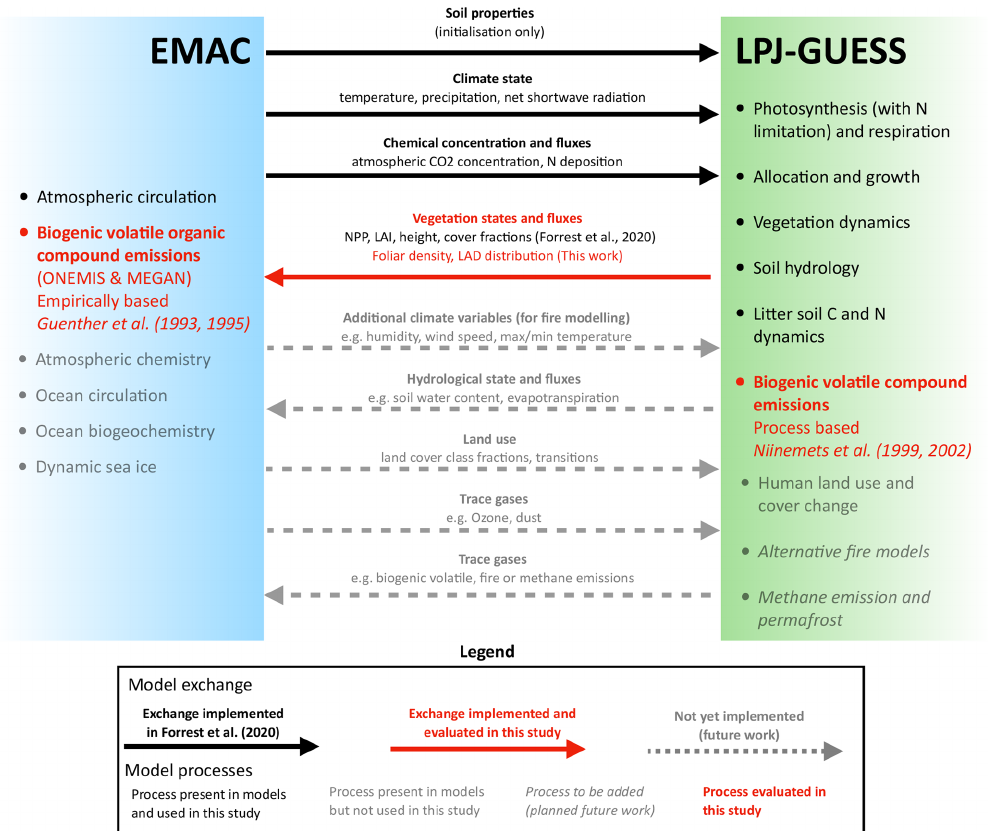
Figure 1. The main processes and exchanges in the coupled model framework adopted from Forrest et al. (2020). Model exchanges in normal black text were included in Forrest et al. (2020) and used in the simulations presented here. Exchanges in red are implemented in this work, while exchanges with grey text and grey dotted arrows are not currently included in the framework but are planned for use in future work. Model processes in normal black text were included in Forrest et al. (2020). Processes in normal grey text were included in Forrest et al. (2020) but not used here, while processes in italicised grey text are not currently included in the framework. Processes in red on the EMAC side (empirically based emissions with interactive vegetation information) are implemented and evaluated in this work, while BVOC emissions in LPJ-GUESS (semi-process based) were already implemented and are only used in this study for comparison with EMAC